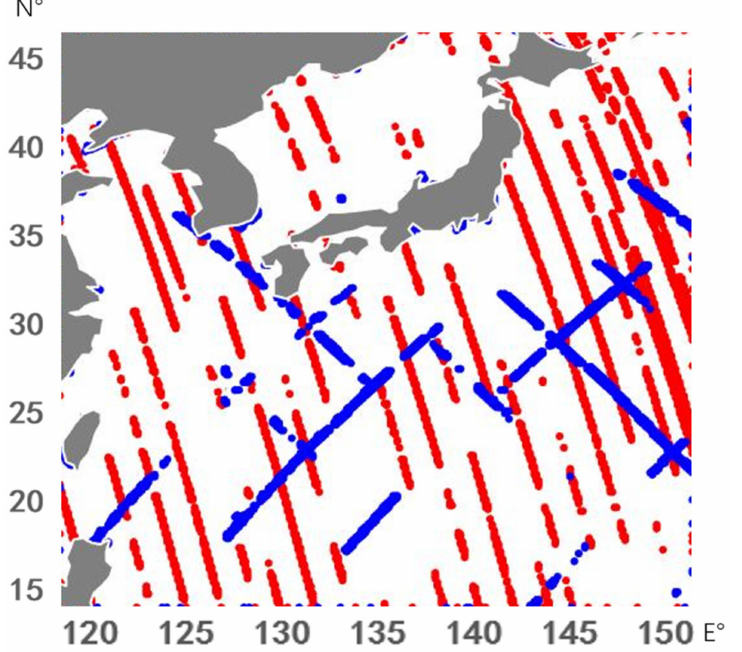
Figure 1. The Trajectories of OCO-2 (red) and OCO-3 (blue) Satellites during